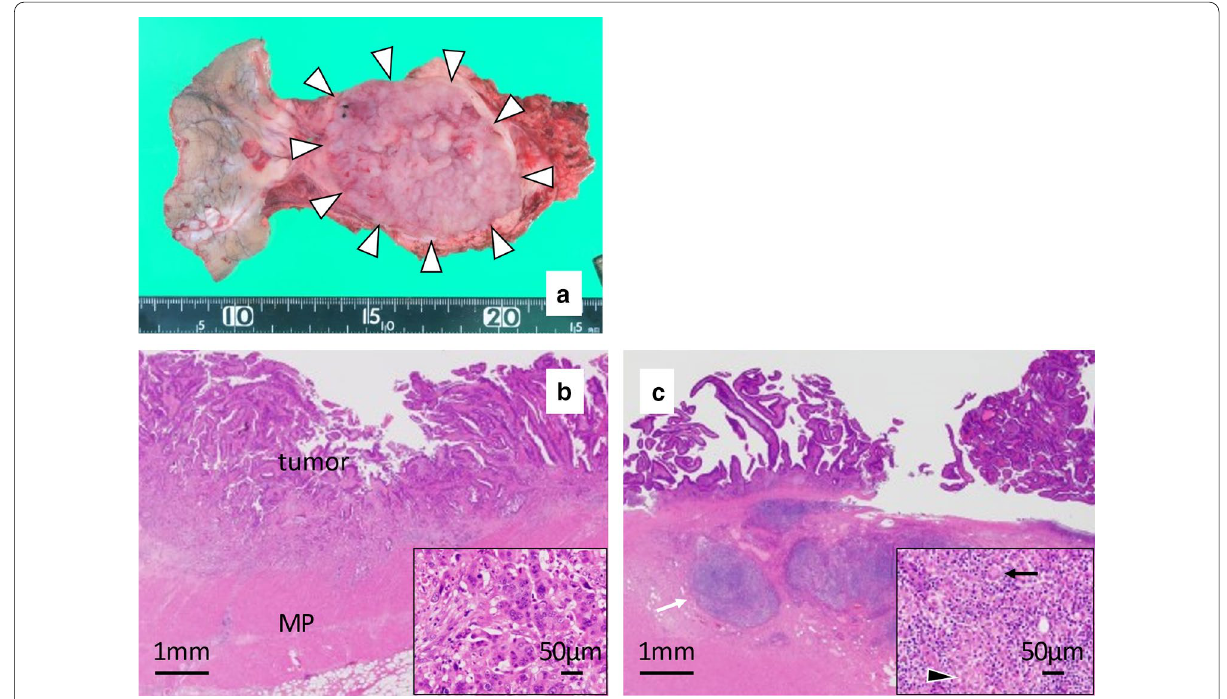
Fig. 3 Pathological findings. a Resected specimen. White arrowheads show the tumor at the residual rectum. b Pathological examination of the rectal tumor with hematoxylin and eosin staining ( 40 and 200). The depth of tumor invasion was pathologically diagnosed as T2. Columnar cells × × with hyperchromatic nuclei proliferating in tubular patterns were seen. Focal non-glandular irregular nests were also observed. The pathological diagnosis was well- to moderately differentiated adenocarcinoma with foci of a poorly differentiated component. MP: muscularis propria. c Pathological examination of the resected residual rectum with hematoxylin and eosin staining ( 40 and 200). At low magnification, mononuclear × × cells (white arrow) were found to have migrated into the submucosal layer. At high magnification, noncaseous epithelioid cell granulomas (black arrowhead) and multinucleated giant cells (black arrow) were seen. These findings are typical pathological observations in patients with Crohn’s